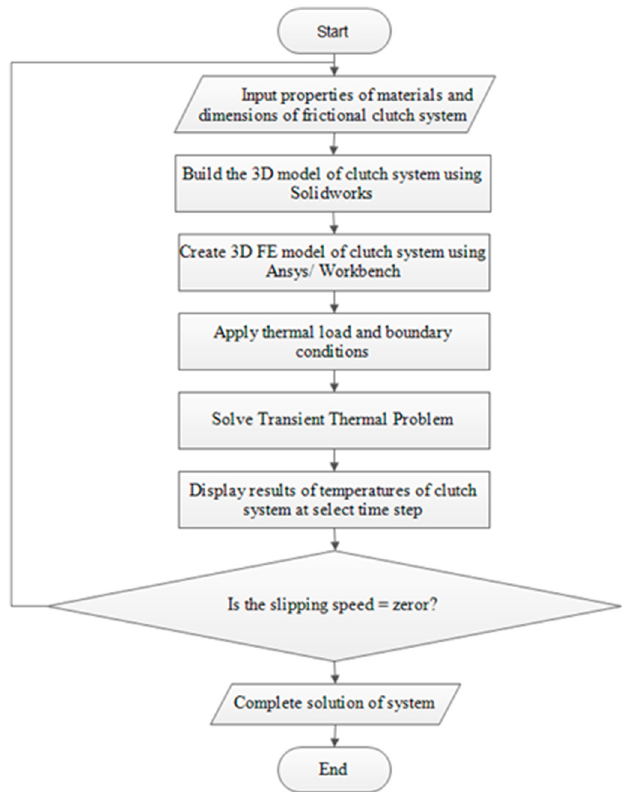
Figure 5. Flowchart of developed numerical approach (FE) to find solution of transient thermal problem.